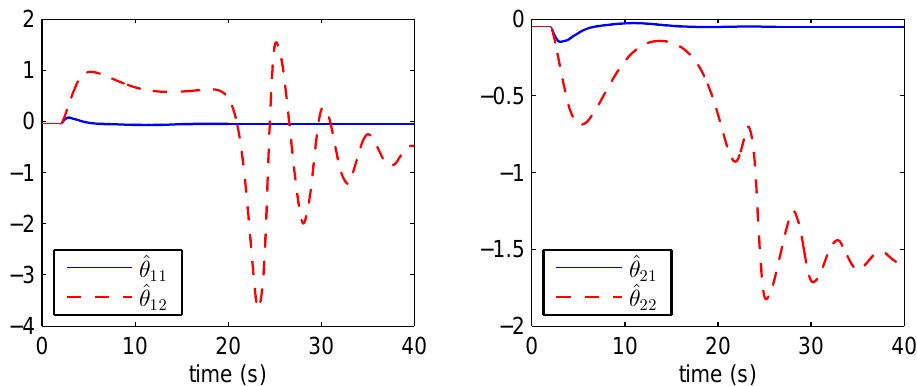
Figure 2. Swing curves of ˆ θ under the controller (34) and the RAC,